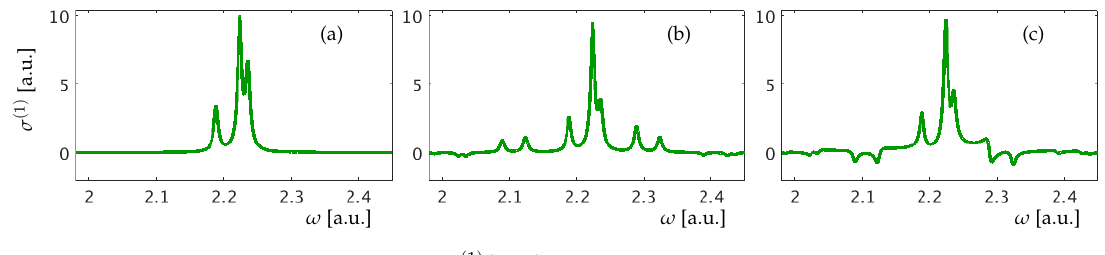
Figure 3. Atomic cross-section σ ( 1 ) ( ω , τ ) at ( a ) τ (cid:28) − 1/ Γ ; ( b ) τ = 0; ( c ) τ = − 0.1/ Γ .